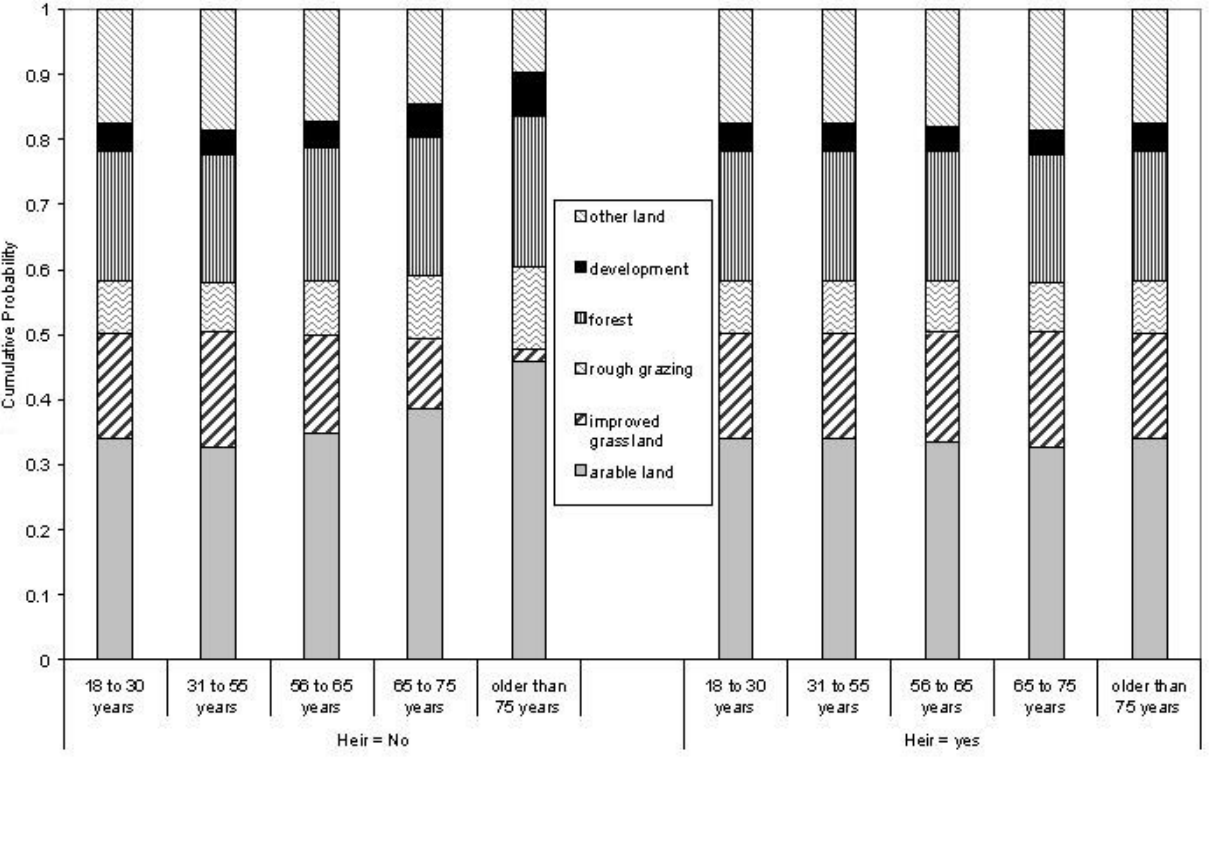
Fig. 7. The probability of land cover for a land manager’s age and